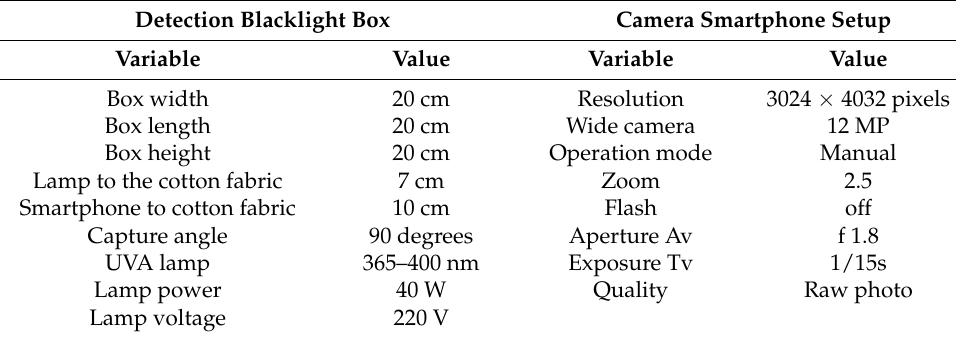
Table 4. Variables of detection blacklight box and camera smartphone